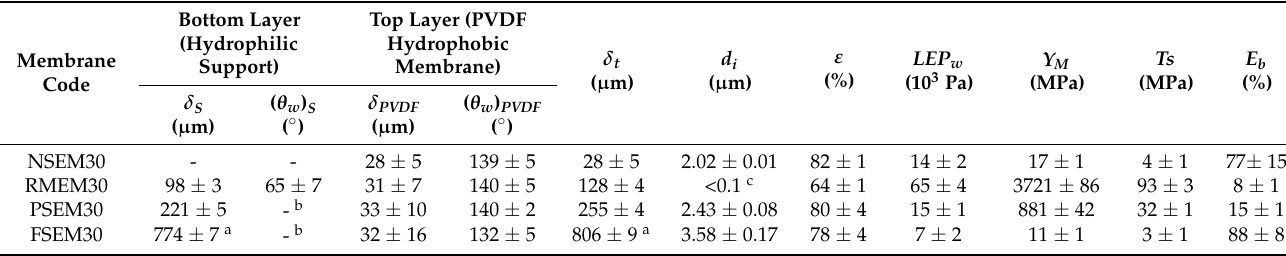
Table 1. Characteristics of electrospun unsupported and supported nanofibrous membranes for 30 min electrospinning time: Thickness ( δ ) and water contact angle ( θ w ) of the top and bottom surfaces of the membrane, total thickness ( δ t ), mean inter-fiber space ( d i ), void volume fraction ( ε ), liquid entry pressure of water ( LEP w ), Young ´ s modulus ( Y M ), tensile strength ( Ts ) and elongation at break ( E b